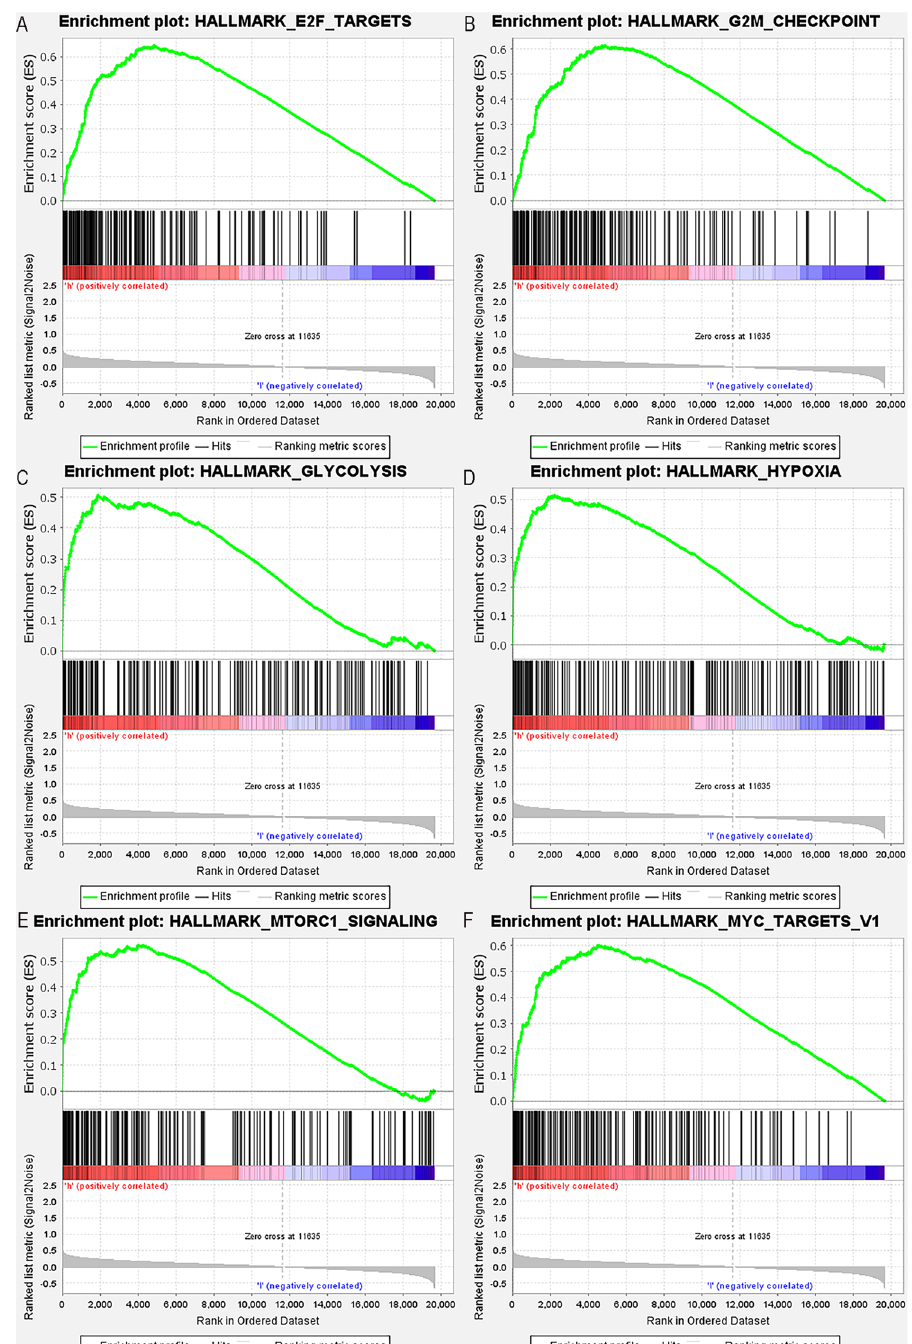
Figure 4. Enrichment plots of hypoxia-related gene sets from gene set enrichment analysis (GSEA). GSEA results show that the gene sets are in ( A ) E2F_TARGETS ( B ) G2M_CHECKPOINT, ( C ) GLYCOLYSIS ( D ) HYPOXIA ( E ) MTORC1_SIGNALING and ( F ) MYC_TARGETS_V1 is rich in differences in high-risk